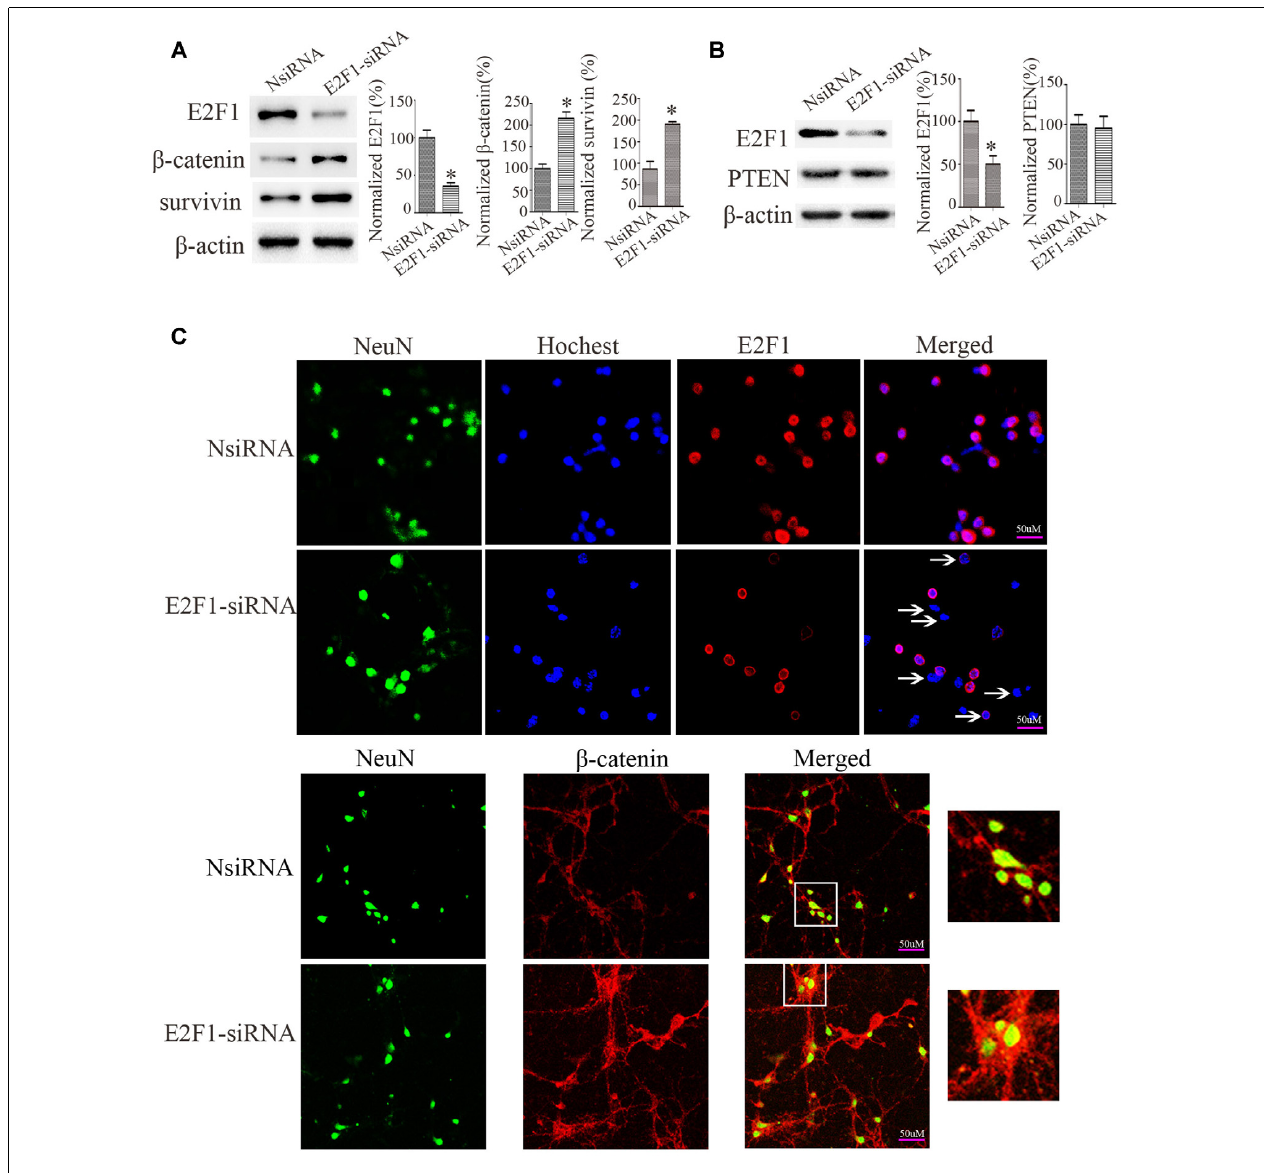
FIGURE 4 | E2F1 knockdown upregulated β -catenin in primary cortical neurons. (A) Western blot showed β -catenin and its target gene survivin were increased when E2F1 was knocked down by E2F1 siRNA. (B) Western blot showed that PTEN was not changed significantly when E2F1 was knocked down by E2F1 siRNA. (C) Rat primary cortical neurons were cultured for 12 days, then treated with E2F1 siRNA for 24 h, and immunofluorescence was used to detect the expression of β -catenin. Results showed that protein levels of β -catenin, which is located in cytoplasm, nuclei, and axon were increased when E2F1 was knocked down in